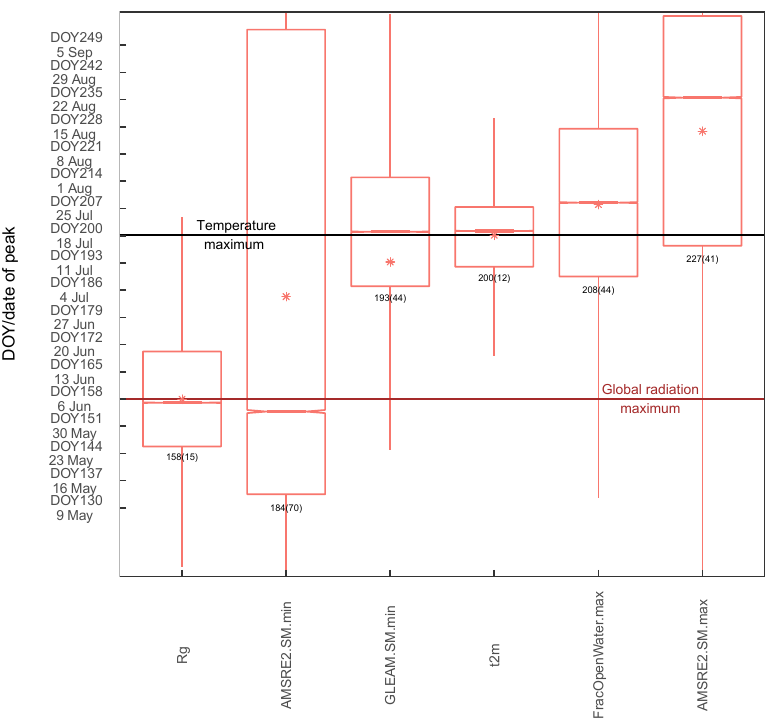
Figure A3. Distribution of the DOY of the peak of the different environmental variables over the study region and between years (spatial sampling matched between data sets for each year). Bars in the boxes indicate the median, stars indicate the mean and the numbers below the bars denote the spatial mean (standard deviation).